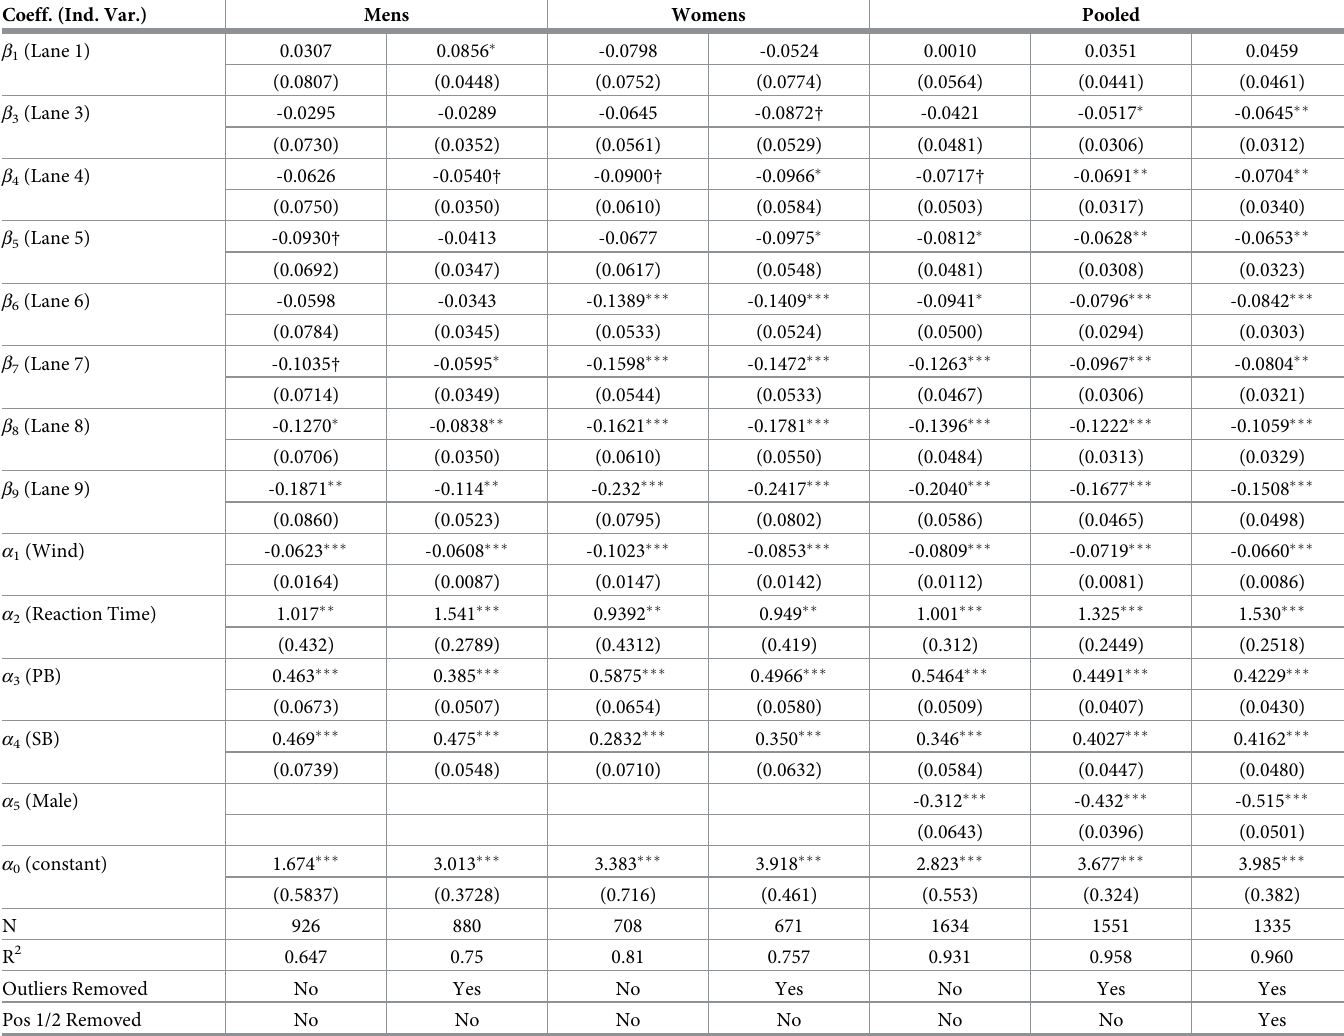
Table 3. Regression results for 200m. Coeff. (Ind.